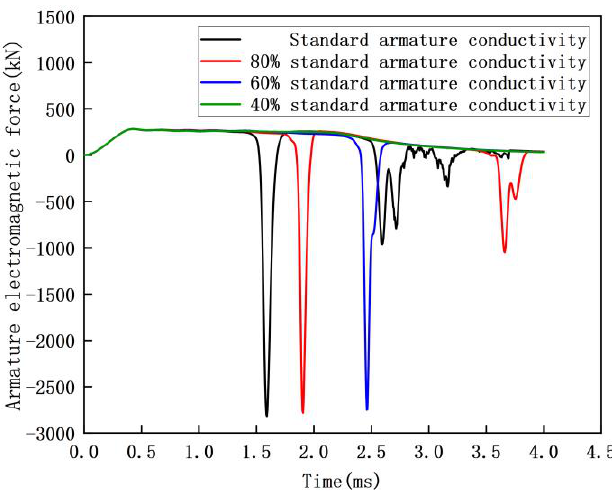
Figure 16. Simulation calculation value of armature electromagnetic force under different armature conductivities in case 2.